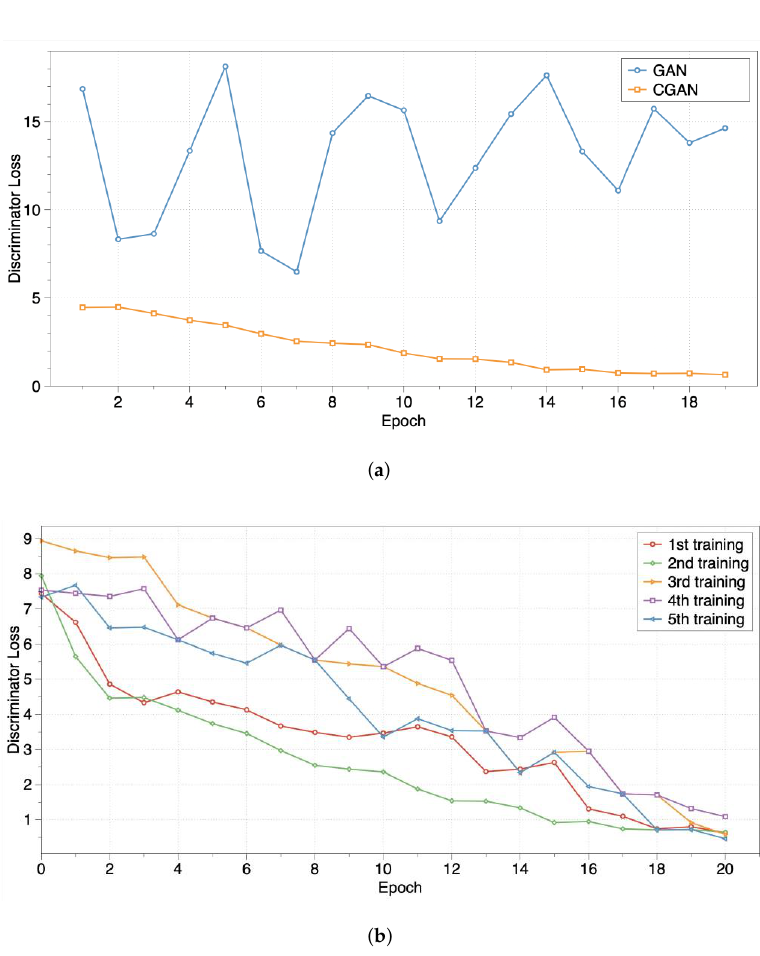
Figure 7. ( a ) Convergence comparisons. ( b ) Stability